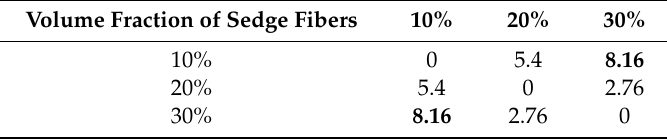
Table 7. HSD test for the tensile strength of the CM sedge fiber-reinforced composites.